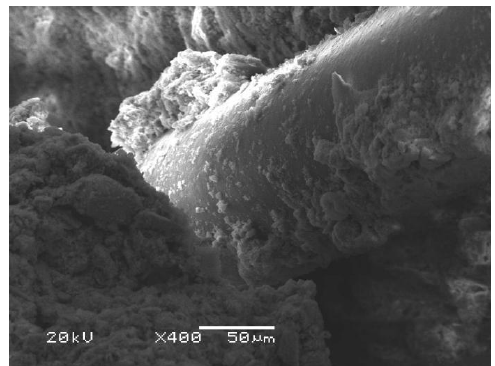
Figure 11. Shape of fiber in the clay.